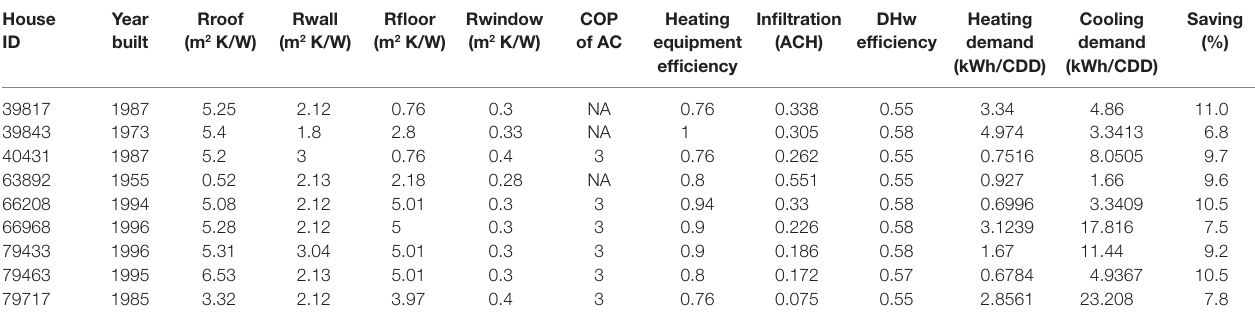
TaBle 8 | savings due to improve of occupants’ behaviors from selected house in Oshawa. house